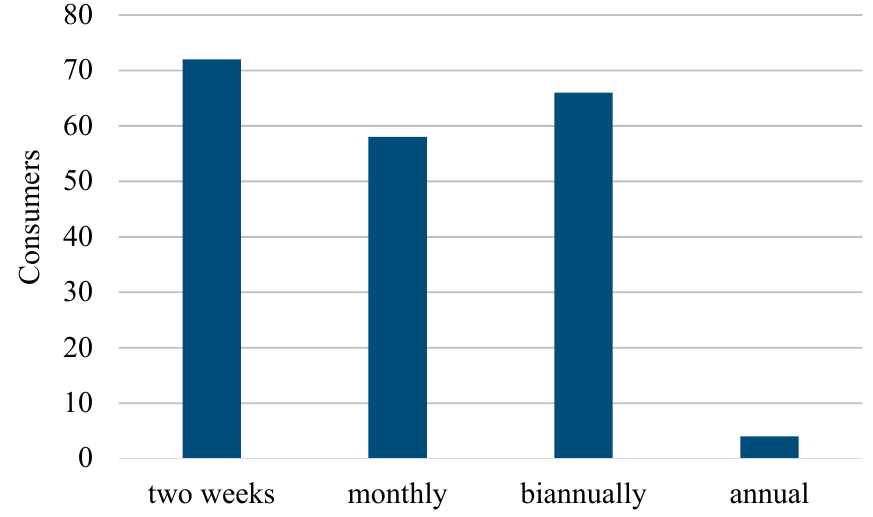
Figure 9. Cleaning frequency in the food compartments.